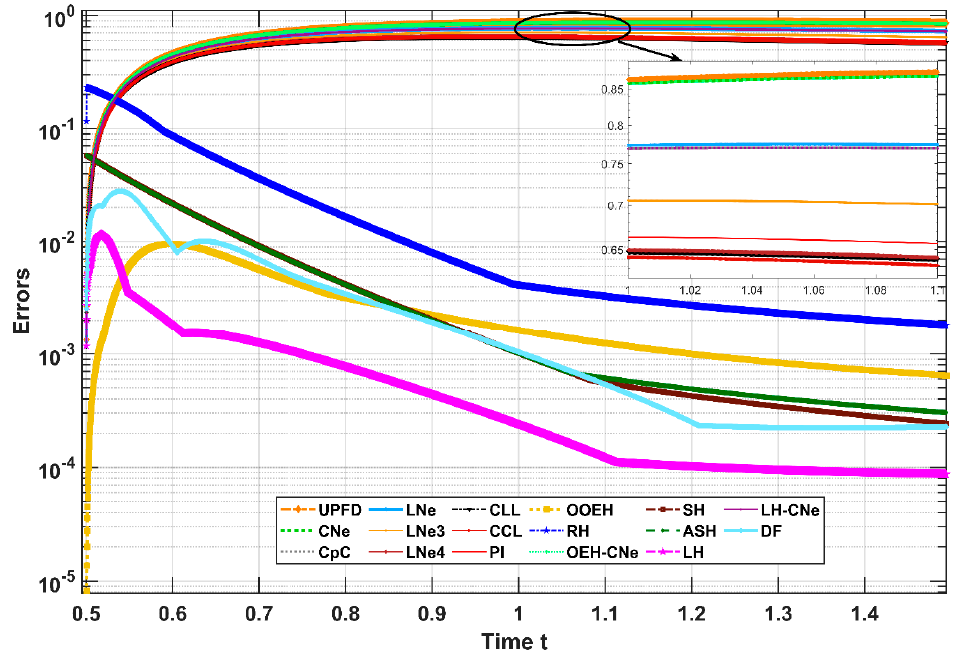
Figure 7. The time development of the errors, i.e., the absolute difference between the analytical solution and that of the stable numerical methods, for ℎ = 2 ⋅ 10 (cid:2879)(cid:2872) as a function of time.